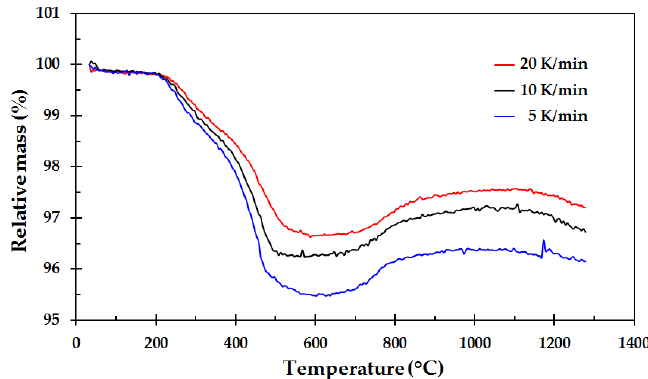
Figure 14. Thermogravimetric analysis of a test specimen from the center of the thermal insulation.